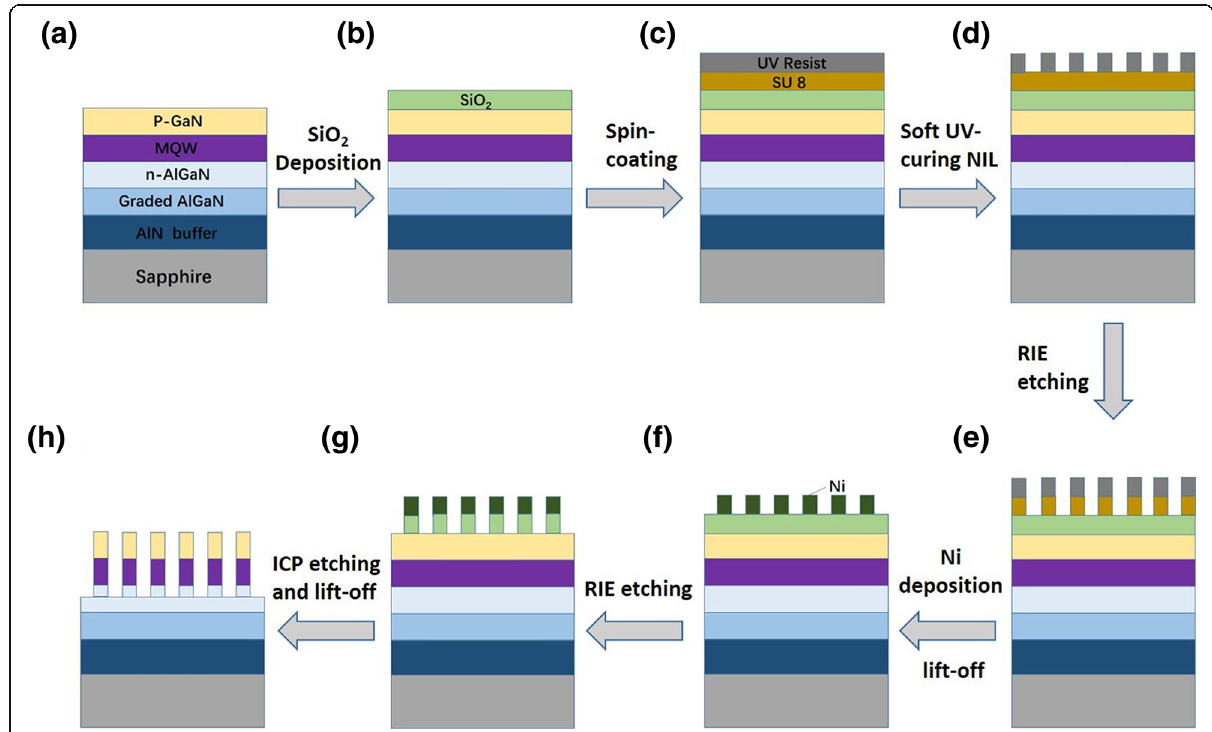
Fig. 1 Schematic of the fabrication of AlGaN NR arrays with MQWs embedded. a Original AlGaN-based deep UV LED wafer. b SiO 2 deposition. c Spin-coating process of the SU8 photoresist and the UV curable resist. d Soft UV-curing NIL process. e RIE process of SU8 photoresist. f Ni deposition and lift-off process in acetone. g Transfer Ni patterns to the SiO 2 layer by RIE. h Transfer patterns from SiO 2 to AlGaN-based LED wafer by